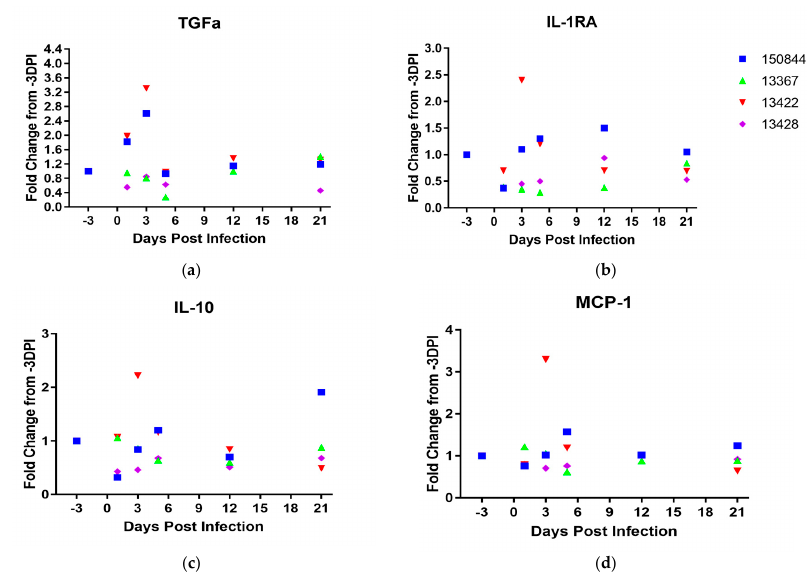
Figure 6. Serum Cytokine Profile. Sera taken from macaques on -3, 1, 3, 5, 12 and 21 dpi were subjected to multiplex analysis for cytokine levels. ( a ) TGF α , ( b ) IL-1RA, ( c ) IL-10, and ( d ) MCP-1. Macaque 150844 seen in blue, 13367 in green, 13422 in red and 13428 in purple. All data points represented as fold change relative to value observed 3 days prior to infection.